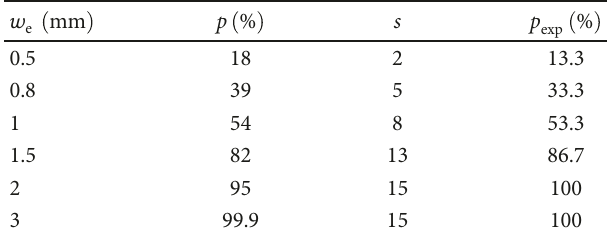
Figure 8: Cumulative density function of the CoG measurement error: experimental (markers) versus numerical (full line). Table 2: Bernoulli checks for di ff erent error